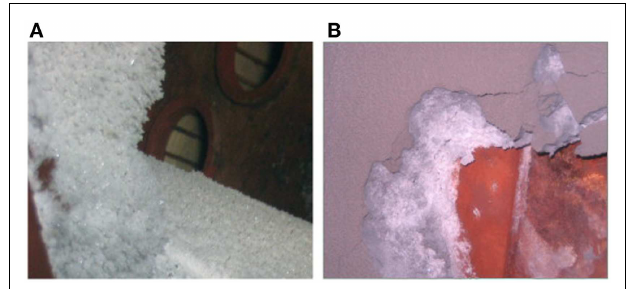
FIGURE 5 | Proposed co-firing model of agro/forestry residues and coal